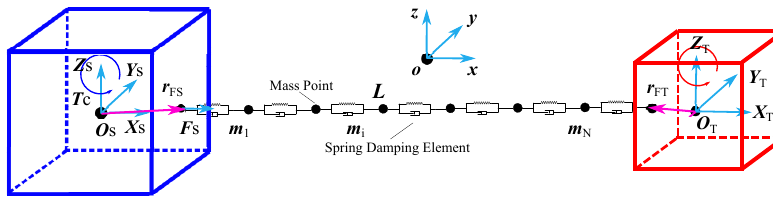
Figure 6. Concept of the lumped-mass model for a single tether configuration.